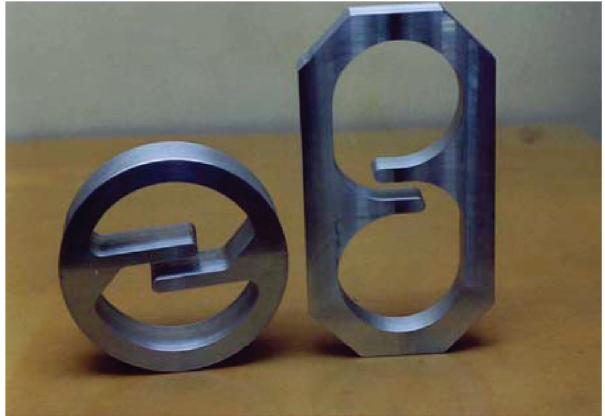
FIG. 15. (Color) Slices of the cylindrical and rectangular rf